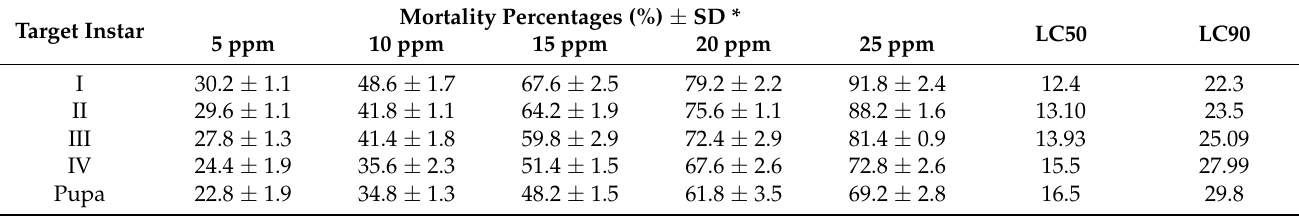
Table 1. The toxicity of biosynthesized MgO-NPs against A. stephensi larvae and pupa. Mortality Percentages (%) ± SD Target Instar